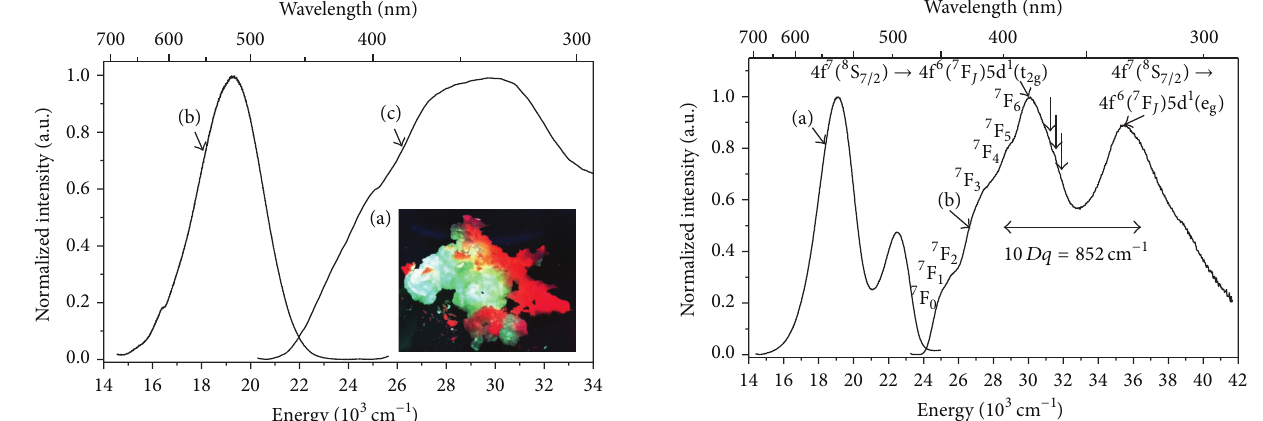
Figure 4: (a) Precursor of 4 irradiated with UV light. (b) Emission = 27 400cm −1 ) and (c) excitation ( ̃𝜐 ( ̃𝜐 ex of 4 after combustion synthesis.